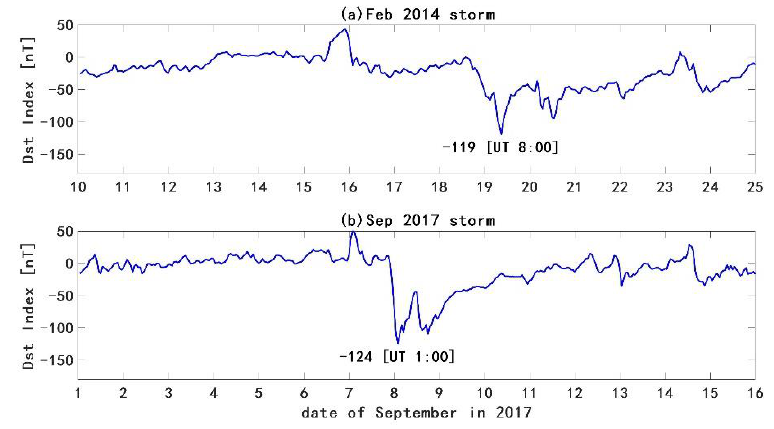
Figure 7. Temporal variation in Dst indices during the two geomagnetic storms.